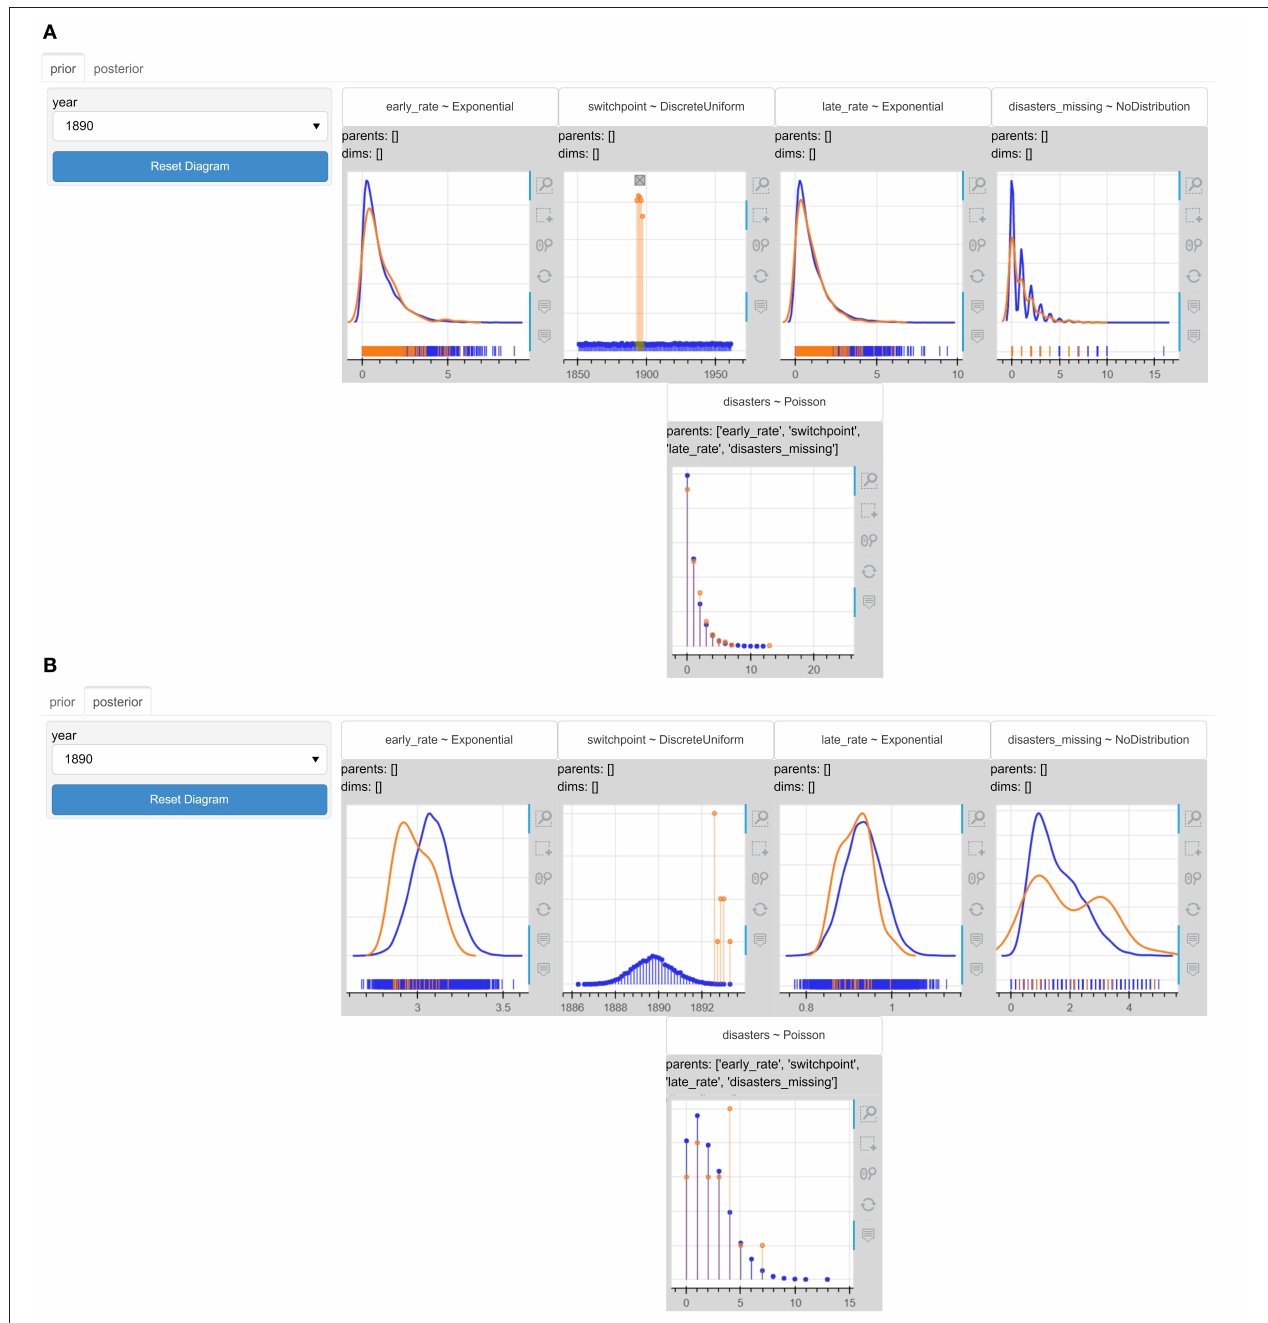
FIGURE 13 | The interactive probabilistic models explorer of the coal mining disasters model. PyMC3 was used for the models’ specification and inference. The updated (A) prior graphical representation, and (B) posterior graphical representation after restricting the switchpoint to values within the interval 1893 − 1897. The posterior predictive probability mass function of the number of disasters in year 1890 shifts toward 4. This is reasonable as we assumed with our conditioning that the regulations changed at a later